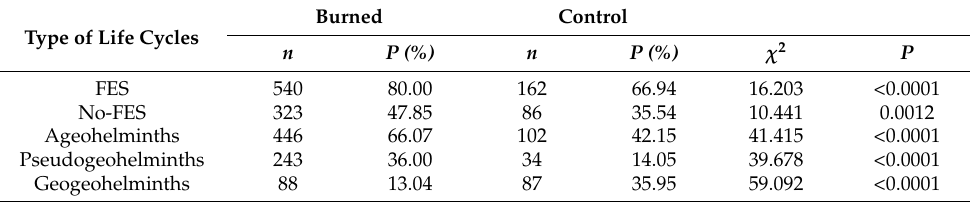
Table 6. Total prevalence (P) of the five types of life cycles in the wood mouse, and parameters of statistically significant differences between them, in the burned (B) and control (C) areas.